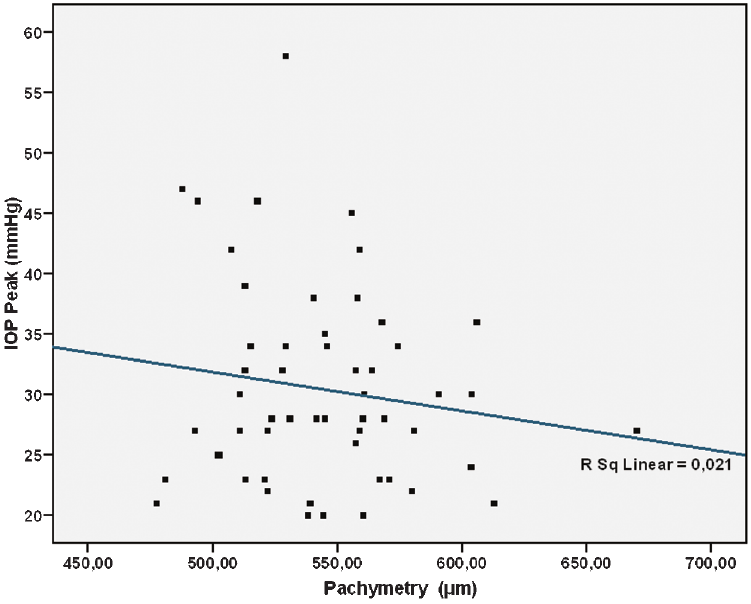
Figure 1 Correlation between Pachymetry and IOP peak in the Water Drinking